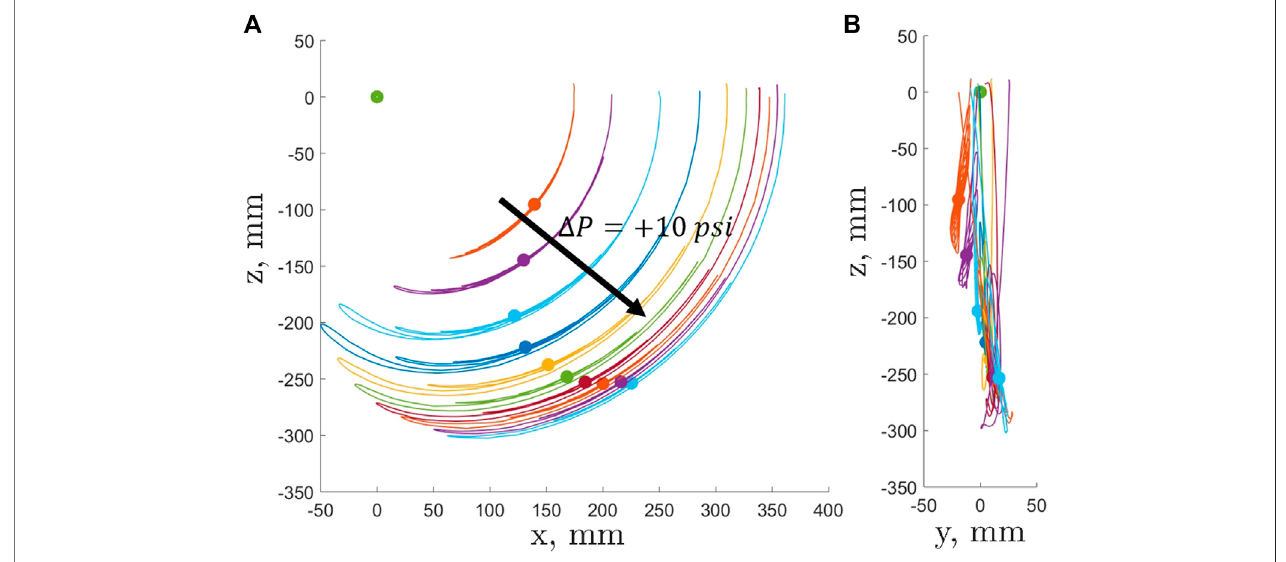
FIGURE 4 | EFAM tip trajectories (solid lines) and static tip positions (circle) in 10 psi increments starting at fi ve psi. The green circle at the axes origin represents position of the base.